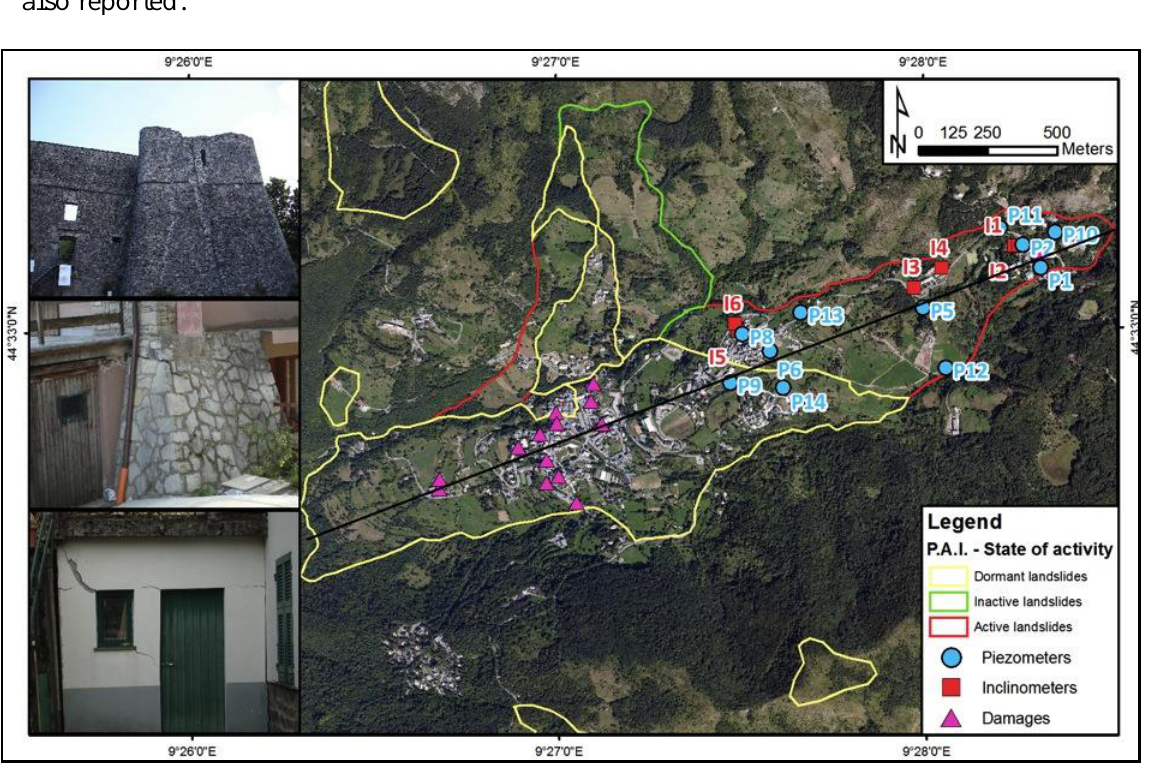
Figure 2. Landslide map with location of the geotechnical monitoring instrumentation and damage to buildings and details of damage. The trace of the section of Figure 3 is also